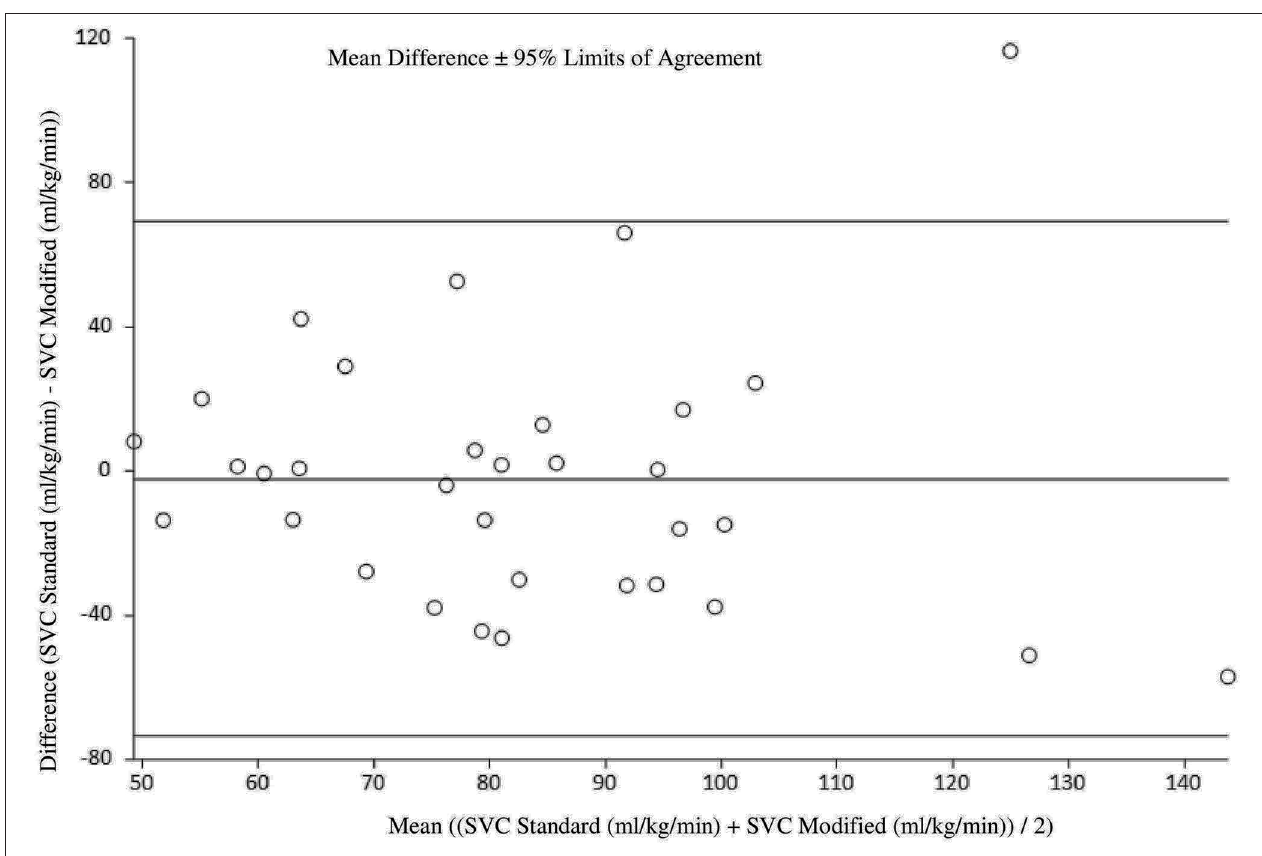
FIGURE 3 | Agreement between standard and modified Superior Vena Cava (SVC) flow measurement at 36h of age with mean difference and 95% limits of